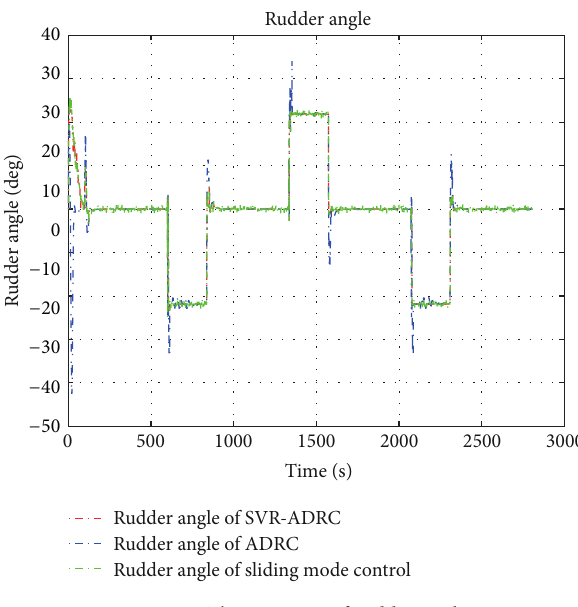
Figure 7: The response of rudder angle.